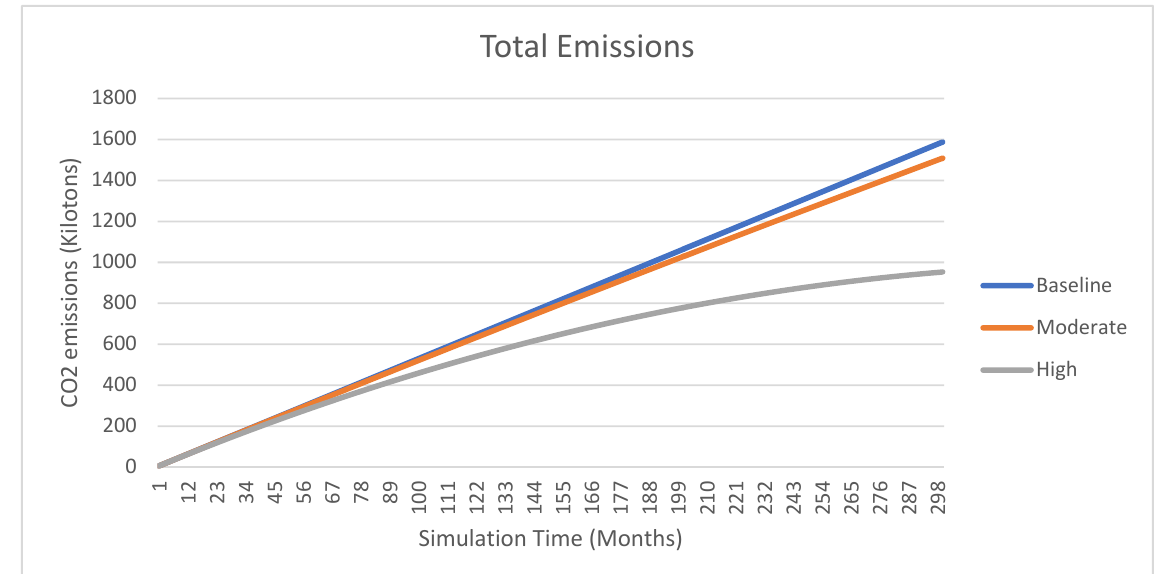
Figure 3. Sensitivity of the model to the impact of grid emission factor. Energies 2021 , 14 , 3115